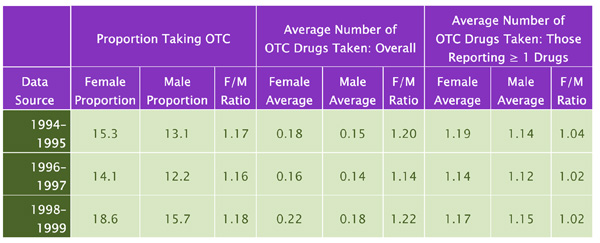
Proportion of Canadians, 20+ Years Using Any Over the Counter (OTC) Medication and Average Number of Different Drugs Used Source: Statistics Canada, NPHS, various years